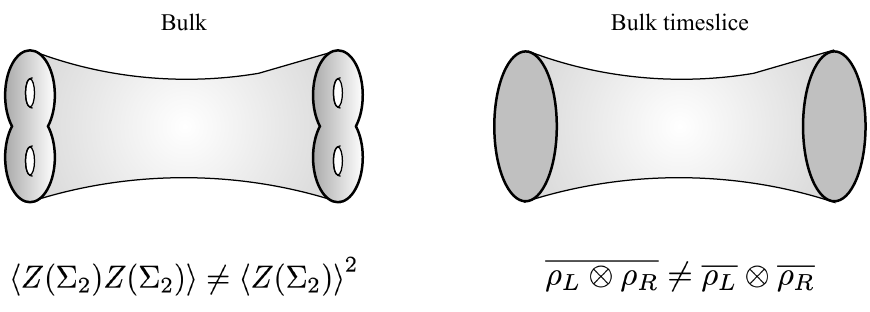
Figure 1 . Left: factorization problem based on spacetime wormholes. Right: a version of fac- torization problem based on spatial wormholes discussed in this paper. Throughout this paper, brackets h· · ·i (without suffix) represent the average over theories, while overlines · · · represent the average over